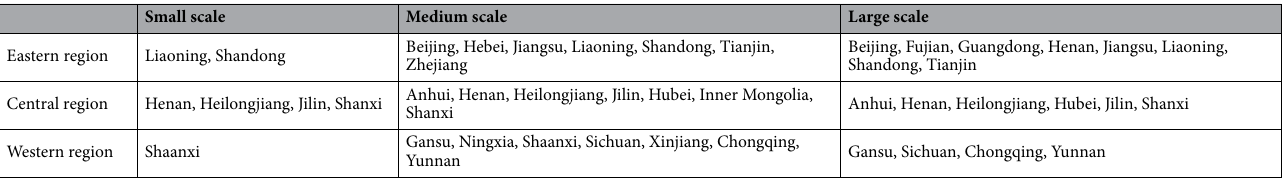
Table 2. Samples selected from 2004–2018.